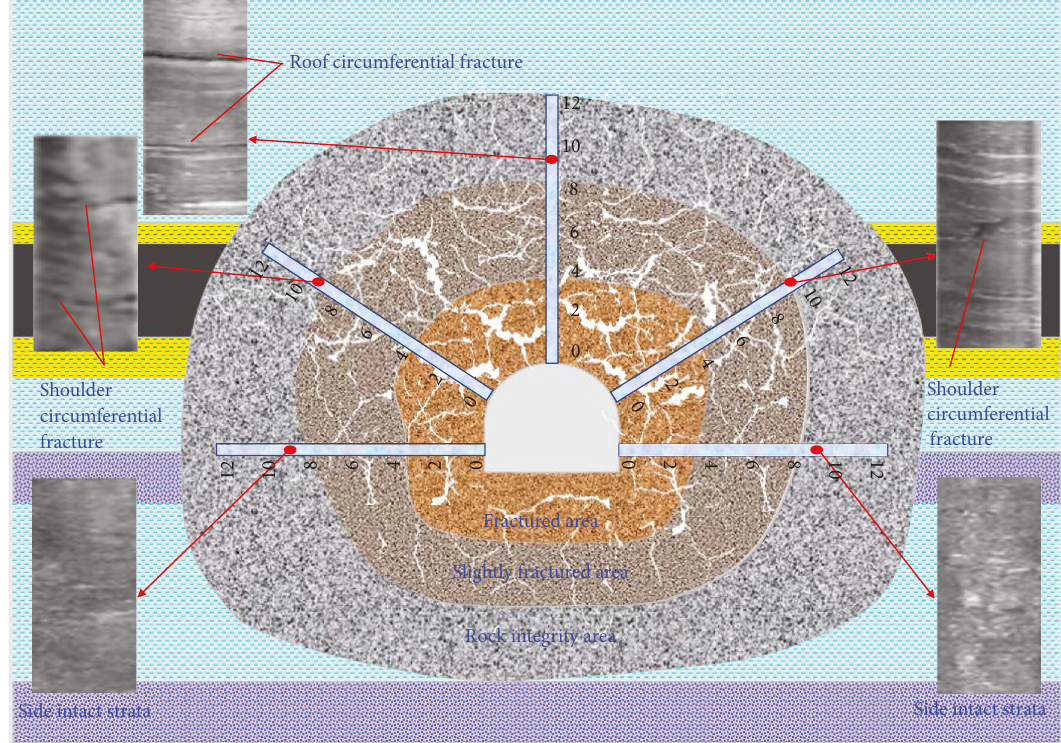
Figure 4: Borehole peep and zoning map (unint: